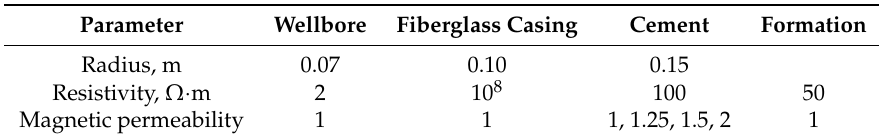
Table 1. Geoelectric model